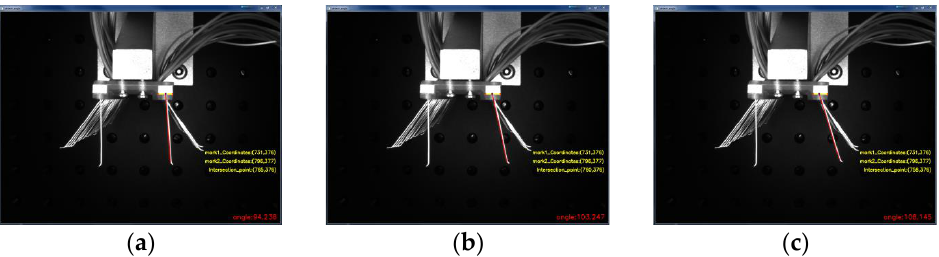
Figure 17. Measured angular values of bristles after rebound: ( a ) 102° springback value, ( b ) 113° springback value, ( c ) 119° springback value.